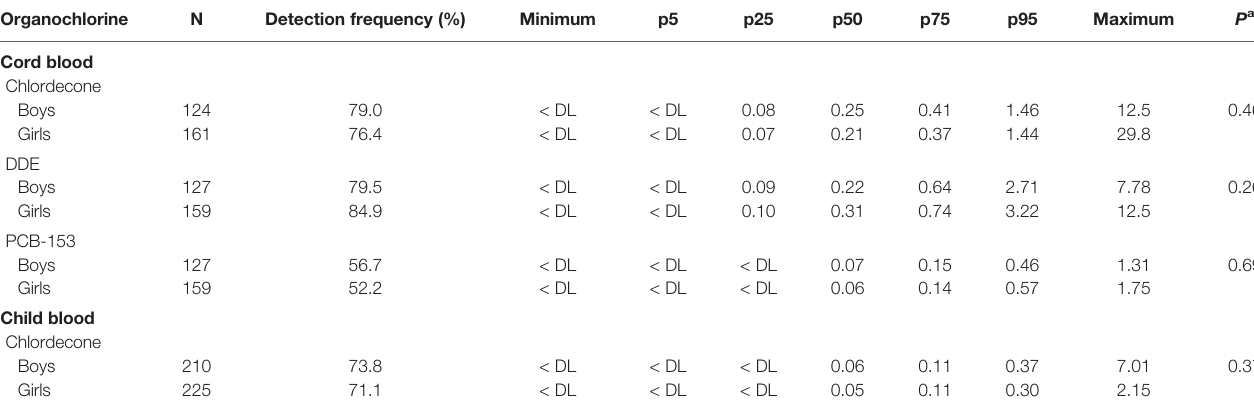
TABLE 2 | Detection and concentrations (µg/l) of organochlorine contaminants in cord and child blood samples. Organochlorine N Detection frequency (%) Minimum Cord blood Chlordecone